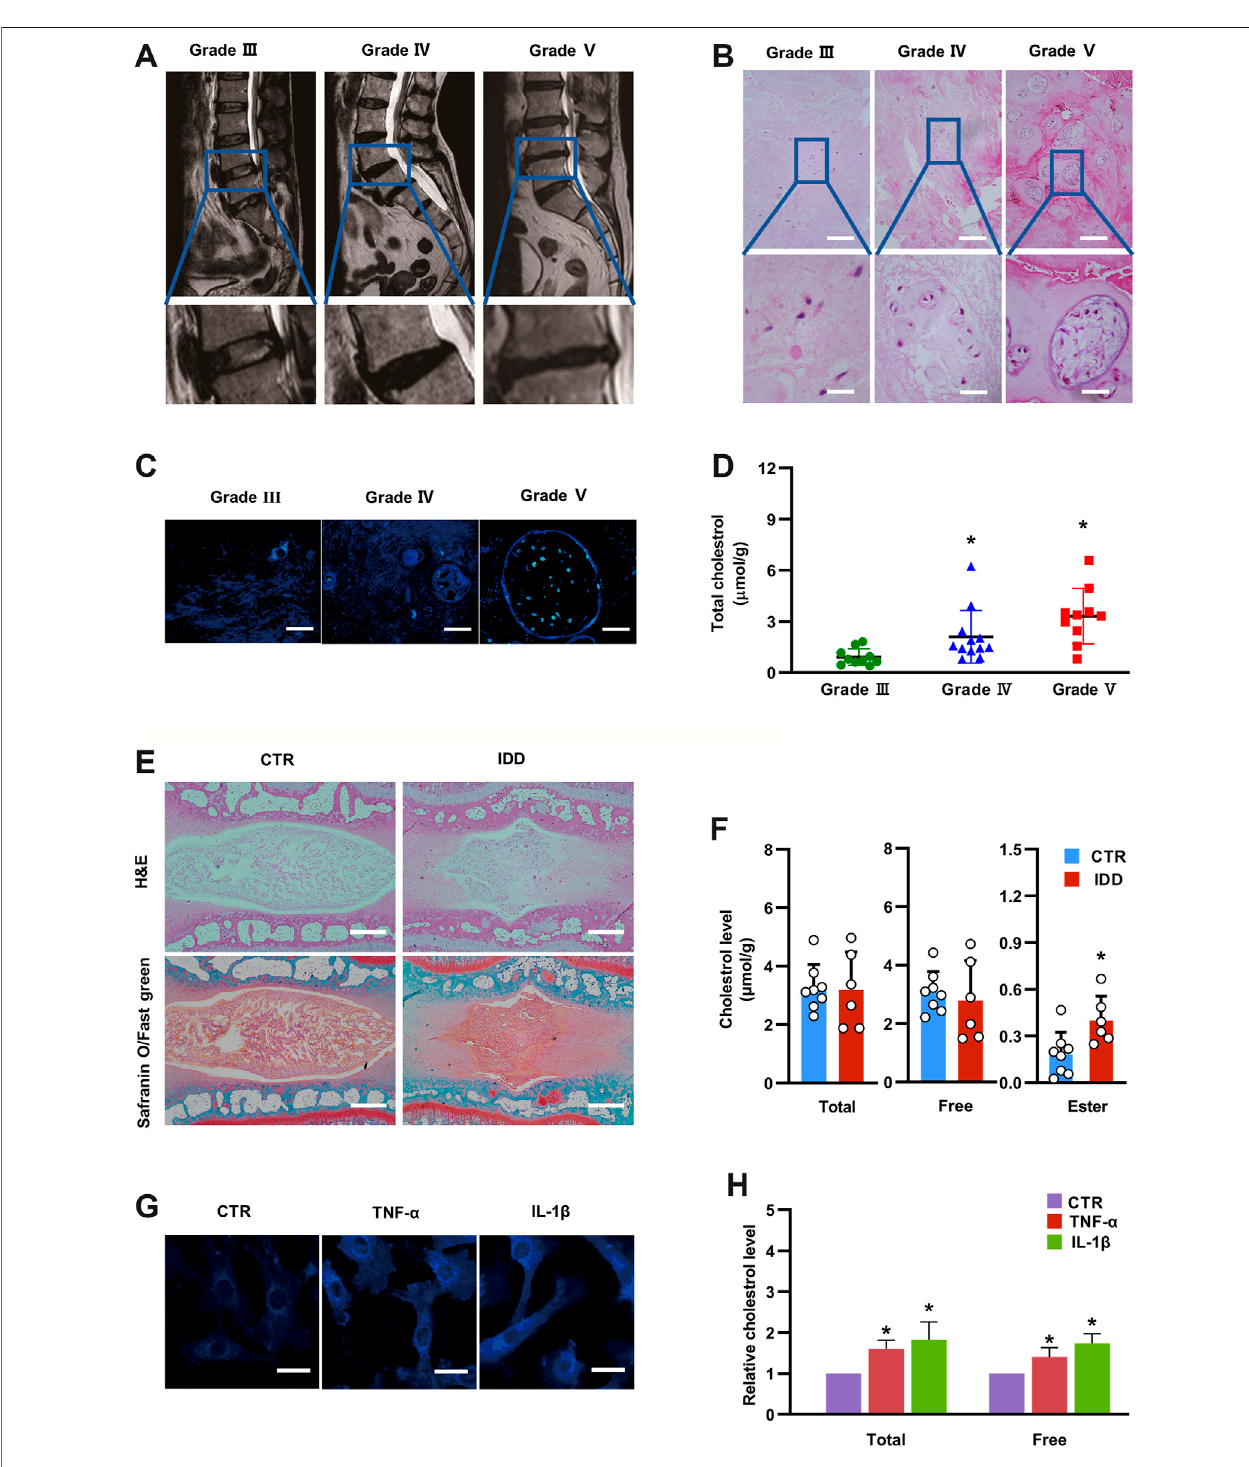
FIGURE 1 | Cholesterol levels are elevated in degenerative NP tissues and in fl ammatory cytokine-treated rat NP cells. (A) Lumbar MRI scans showing different degrees of IDD. (B) H&E staining of degenerative NP tissues from patients (upper panel, bar (cid:1) 200 μ m; lower panel, bar (cid:1) 50 μ m). (C) Filipin staining to detect free cholesterolindegenerativeNPtissuesfrompatients(bar (cid:1) 50 μ m). (D) TotalcholesterollevelswereelevatedindegenerativehumanNPtissueswithincreasedseverity(n (cid:1) 10 – 12). (E) Representative H&E and Safranin O/Fast green staining of rat intervertebral discs (bar (cid:1) 500 μ m). (F) Levels of total cholesterol, free cholesterol and cholesterolesterinpuncturedratNPtissuesandcontrolNPtissues(n (cid:1) 6 – 8). (G) FilipinstainingofNPcellsshowingincreasedfreecholesterol levelsafterTNF- α (50 ng/ ml) and IL-1 β (10 ng/ml) stimulation (bar (cid:1) 30 μ m). (H) The levels of total cholesterol and freecholesterol were elevated in NP cells treated with TNF- α (50 ng/ml) or IL-1 β (10 ng/ml) for 24 h (n (cid:1) 3). The data are presented as the mean ± SD. * p < 0.05.